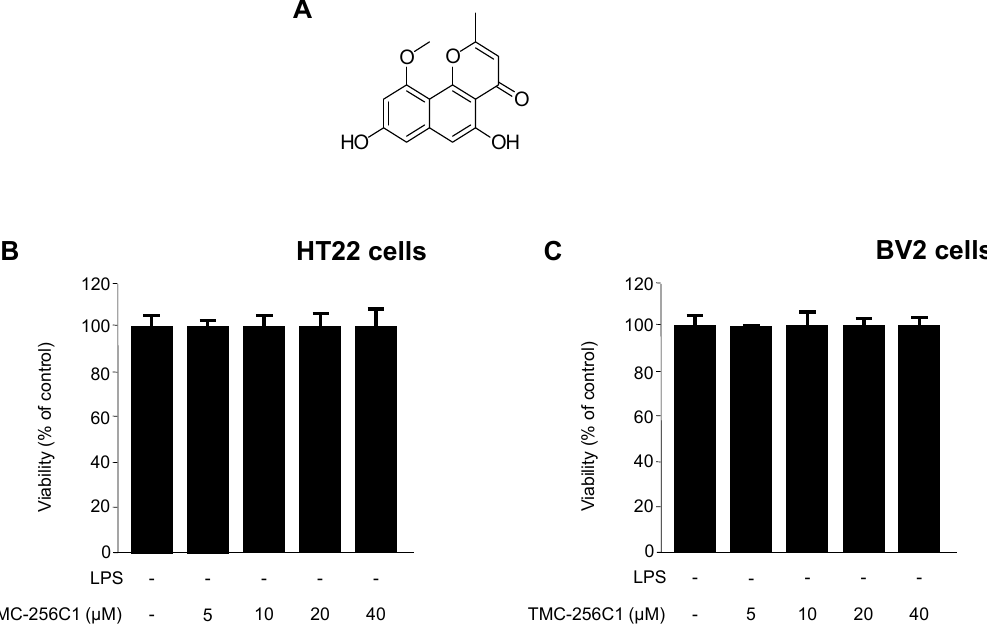
Figure 1. Chemical structure of TMC-256C1 ( A ); and effect of TMC-256C1 on cell viability ( B , C ). HT22 and BV2 cells were incubated for 24 h with various concentrations of TMC-256C1 (5–40 μ M). Cell viability was determined as described in the Experimental Section. Bar represents the mean ± standard deviation (SD) of three independent experiments.